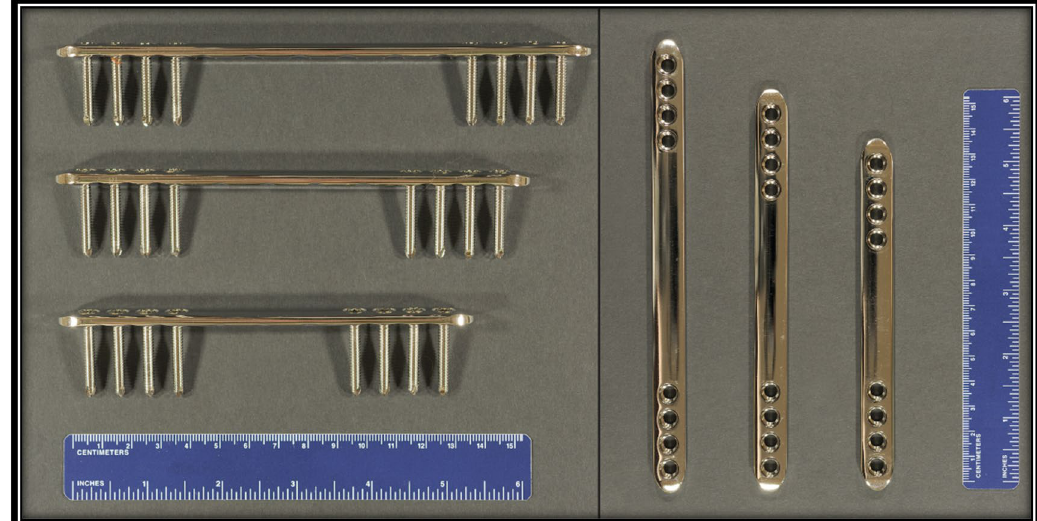
Fig. 2 Custom‑designed low contact, round screw hole, double threaded 8‑hole, 4.5‑mm thick locking plates. Three plate lengths were utilized: 14 cm, 16 cm, and 18 cm. In surgery, the plate was centered over the ostectomy and secured with eight 4.0‑mm diameter locking‑head self‑tapping screws, four in the proximal tibial segment and four in the distal tibial segment. Fixation working length directly reflected the plate length